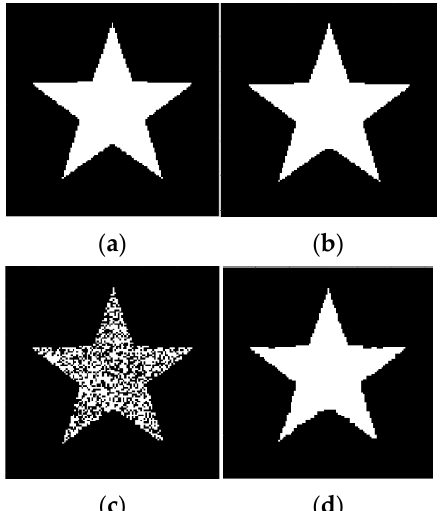
Figure 4. Results of reconstruction of five-pointed star based on qualitative data. ( a ) Original star; ( b ) Reconstructed star; ( c ) Original strong noisy star; ( d ) Reconstructed noisy star.